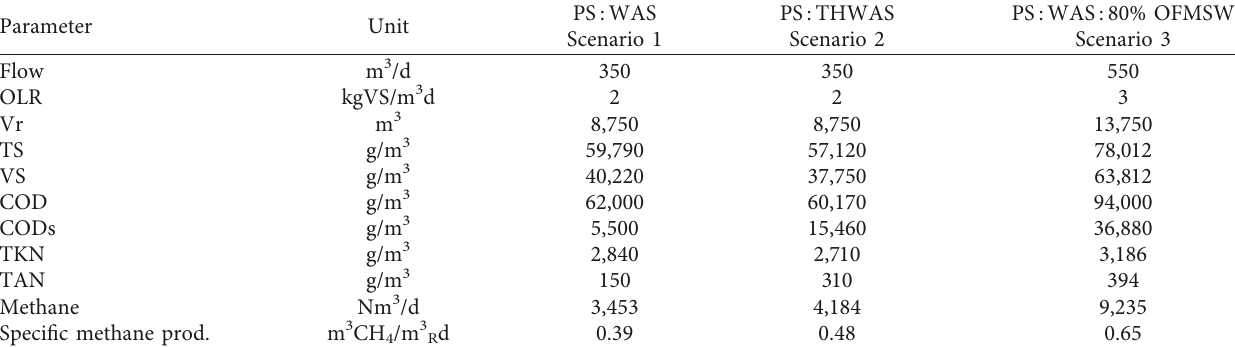
Table 2: Characterisation of the AD substrate and methane production in different scenarios.